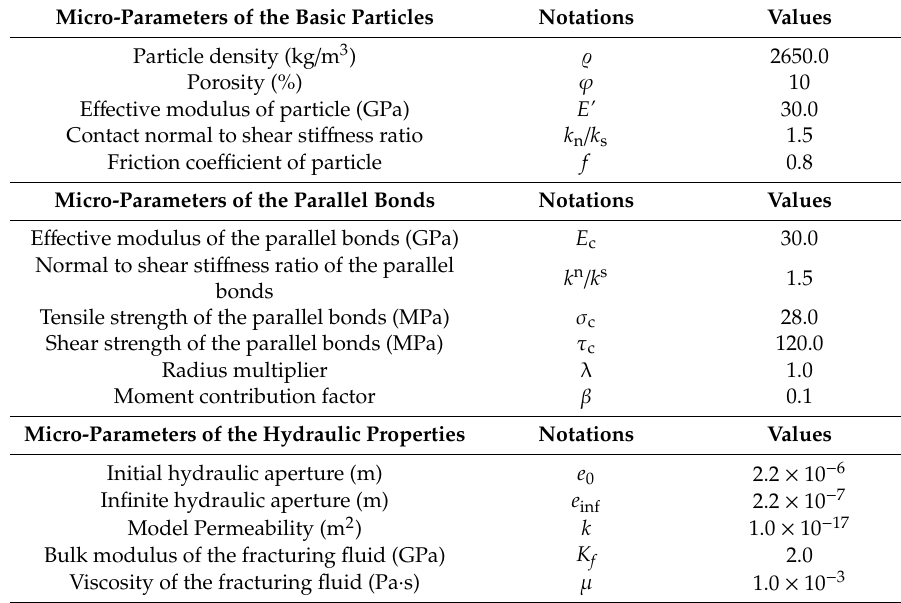
Table 1. Calibrated Micro-Parameters in the Numerical Models of Alax Porphyritic Granite.